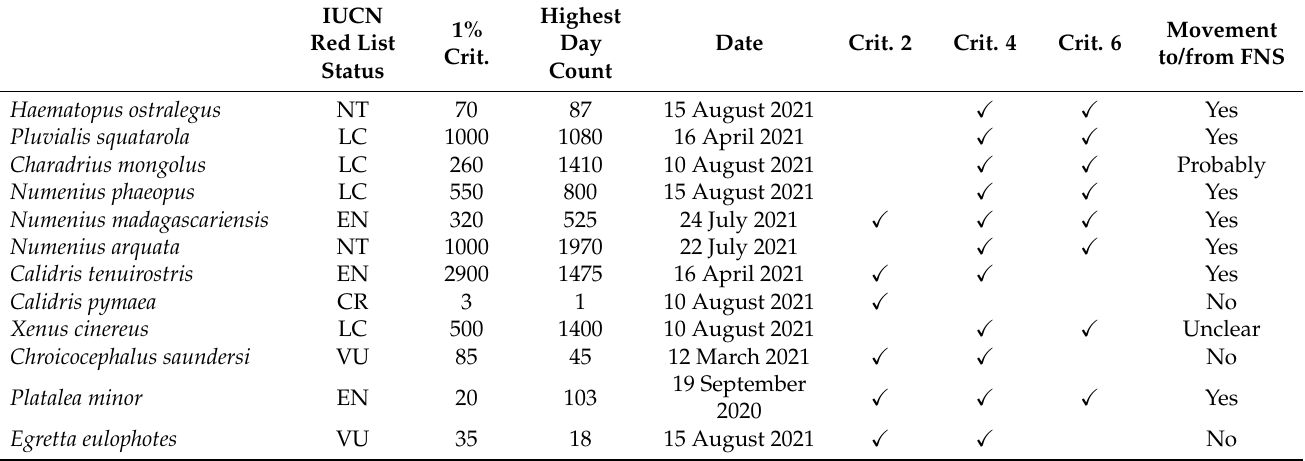
Table 6. Waterbirds which qualify under or contribute to Ramsar Criteria 2, 4 or 6 counted at Maehwari Tidal Flat (July 2020–August 2021); and evidence of their dependence on the Hwaseong Reclamation Lake for roosting during spring high tides. Crit. stands for Ramsar